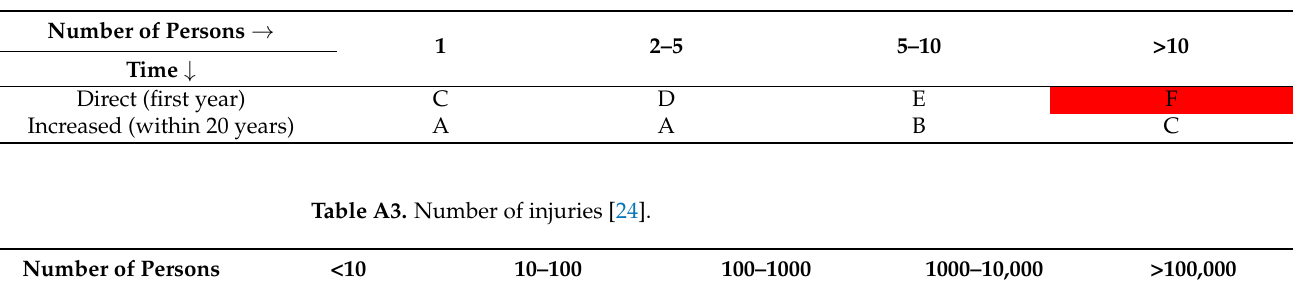
Table A2. Number of deaths [24].